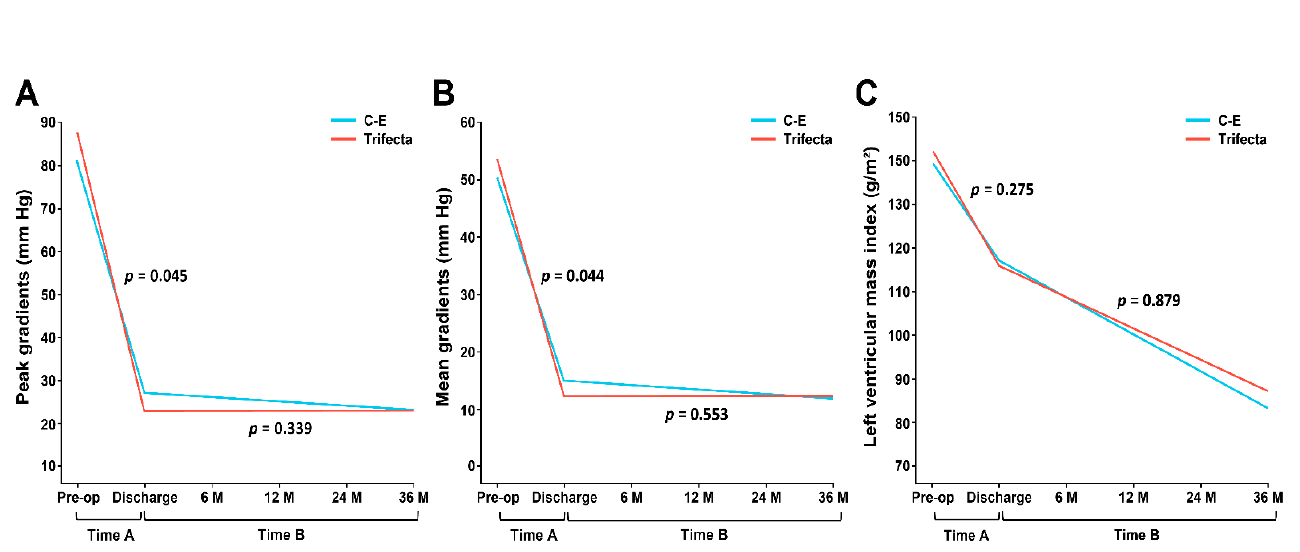
Figure 2. Changes in echocardiographic measurements over time for the Carpentier-Edwards (C-E) and Trifecta valves: ( A ) Peak gradient from baseline to discharge (Time A) and from immediately after surgery to 3 years postoperatively (Time B); ( B ) Mean gradients following the same timeline; ( C ) Left ventricle mass index (LVMI). No significant time-valve effects on gradients or LVMI were found. p -values shown for analyses from baseline to discharge (Time A) and the interaction of the mixed model.